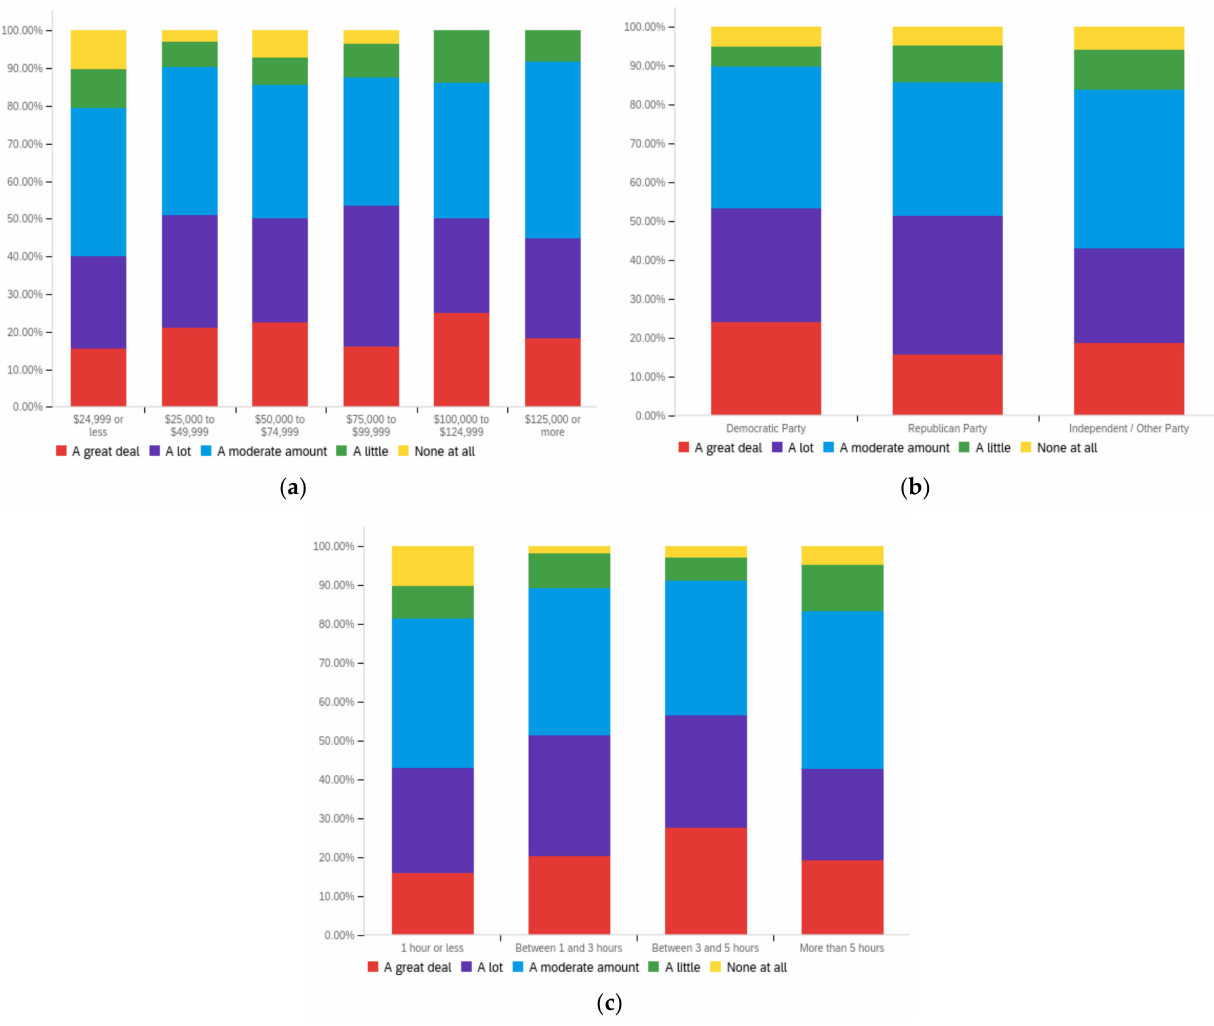
Figure A2. Article title—others’ perception impact by: ( a ) income level (top left), ( b ) political affiliation (top right) and ( c ) online usage